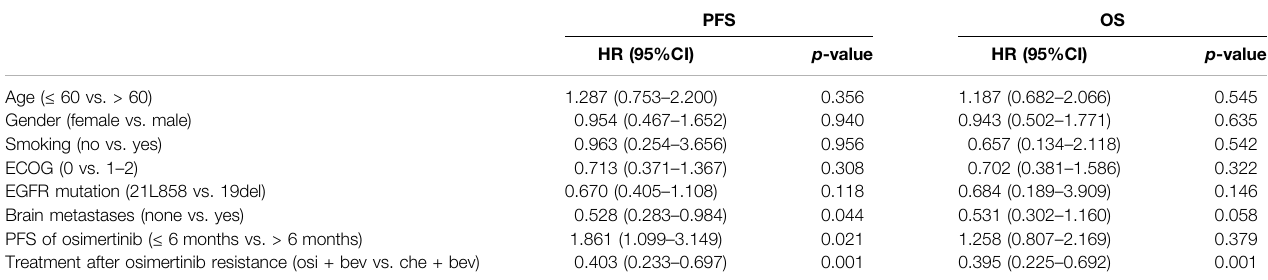
PFS OS HR (95%CI) p -value HR (95%CI)